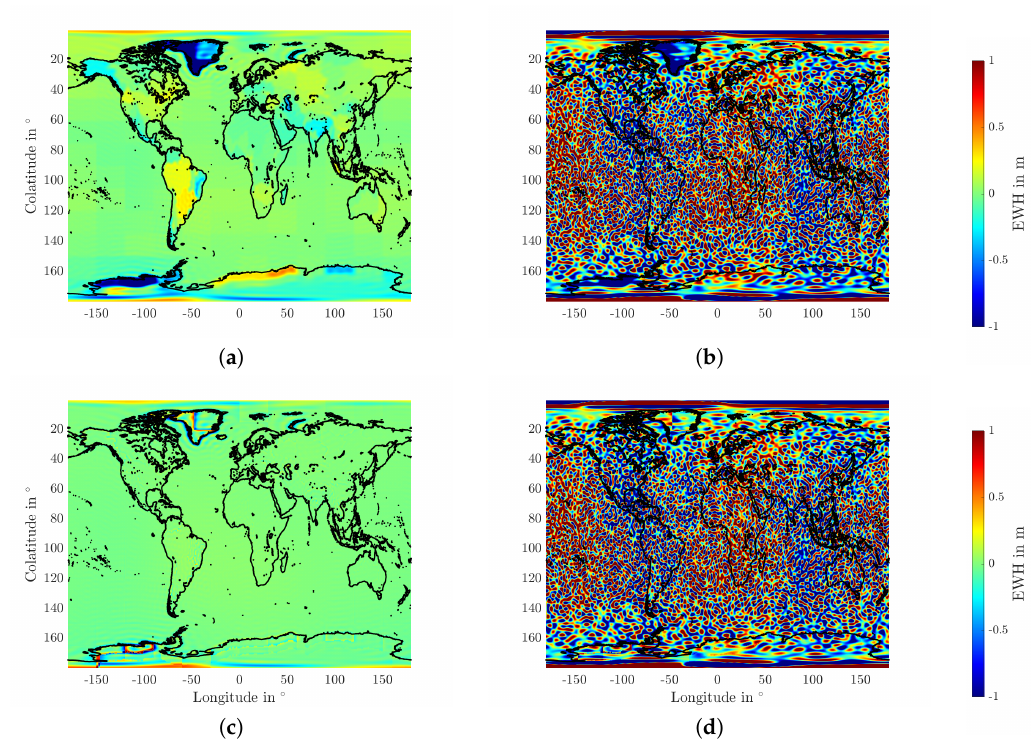
Figure 10. SH d/o 100 models resulting from ( a ) noise-free and ( b ) colored-noise synthetic SGG data generated as described in Section 2.1.2. Panels ( c , d ) show the differences of the models ( a , b ) to the original signal shown in Figure